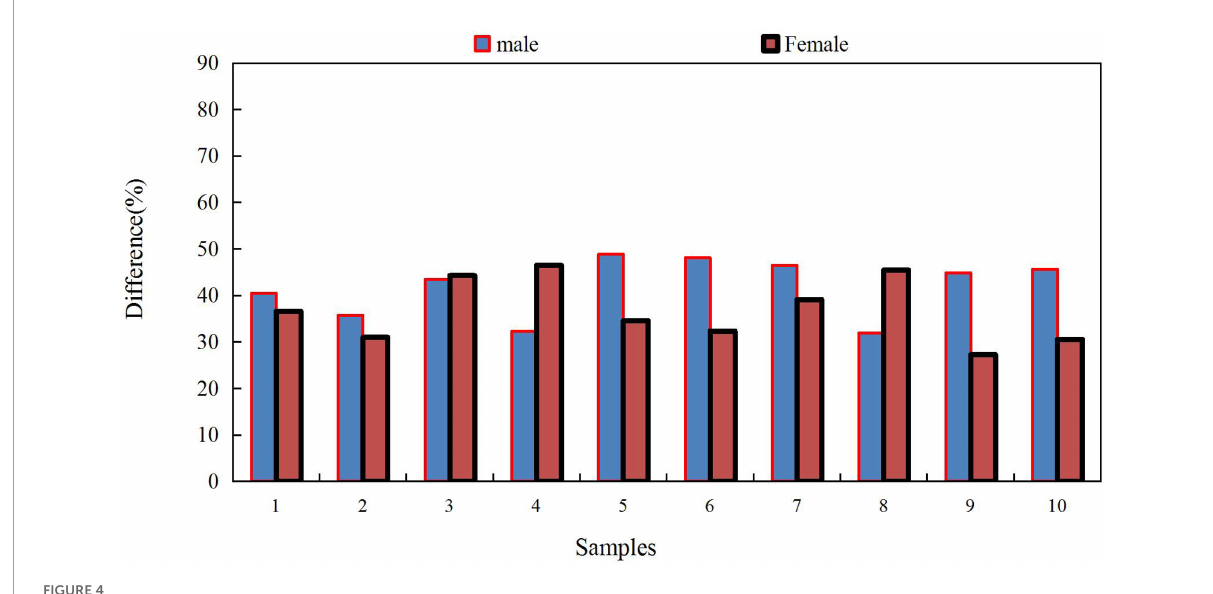
FIGURE4 Differences in the performance of male and female college students.